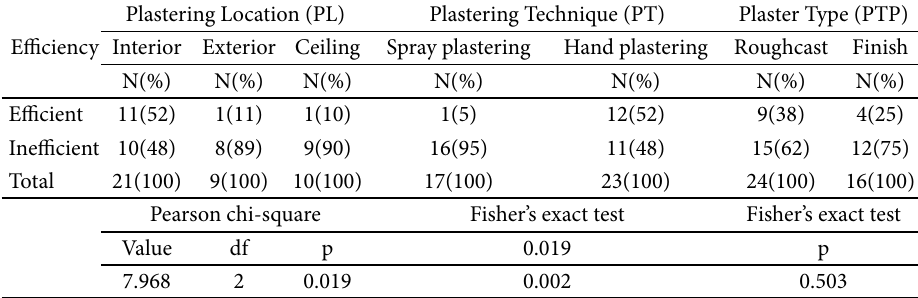
Table 6. Contingency table for efficiency vs. plastering work